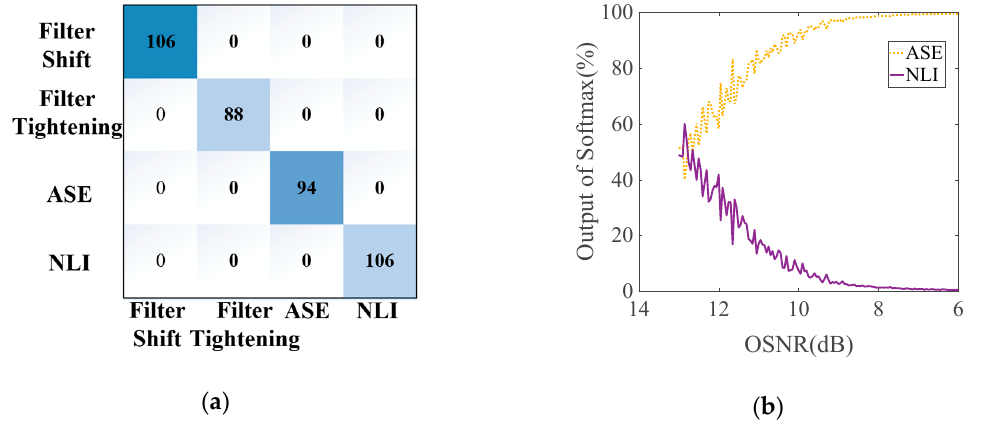
Figure 5. The performance of the method in [12]. ( a ) The accuracy of the proposed method. ( b ) The probability information output by the softmax layer.